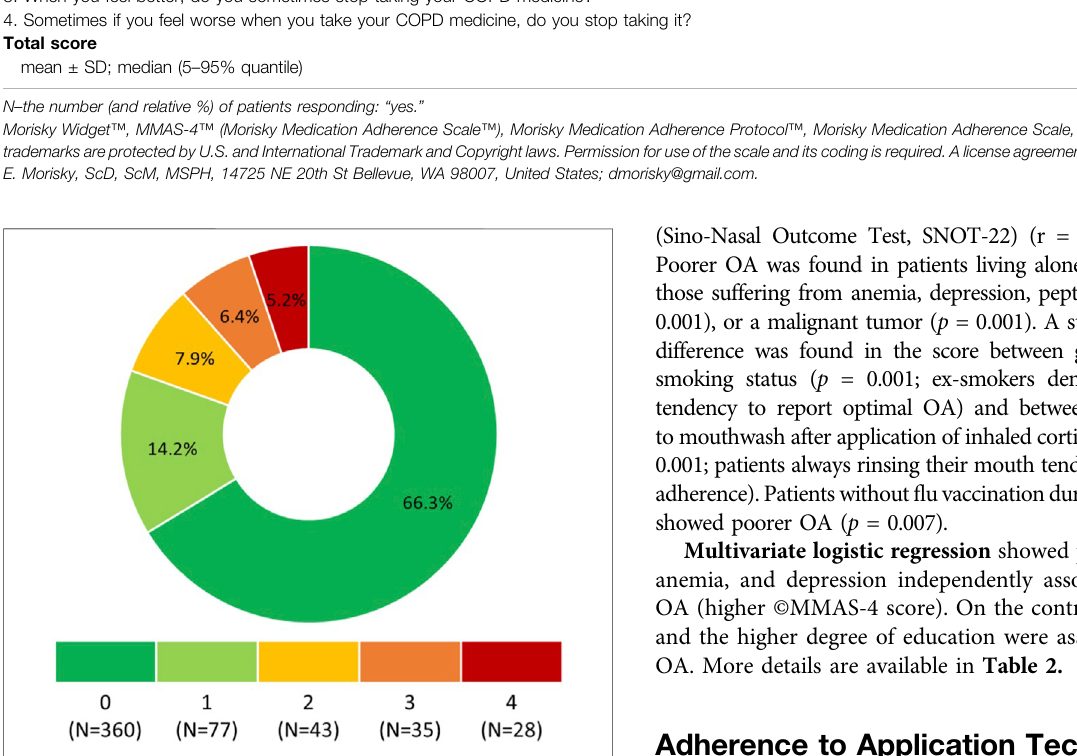
FIGURE 1 | Morisky Medication Adherence Scale (©MMAS-4) score. 0pointsmeansthehighest adherence, 4pointsmeansthelowestadherence. Morisky Widget ™ , MMAS-4 ™ (Morisky Medication Adherence Scale ™ ), Morisky Medication Adherence Protocol ™ , Morisky Medication Adherence Scale, content, name, and trademarks are protected by U.S. and International Trademark and Copyright laws. Permission for use of the scale and its coding is required. A license agreement is available from Donald E. Morisky, ScD, ScM, MSPH, 14725 NE 20th St Bellevue, WA 98007, United States;